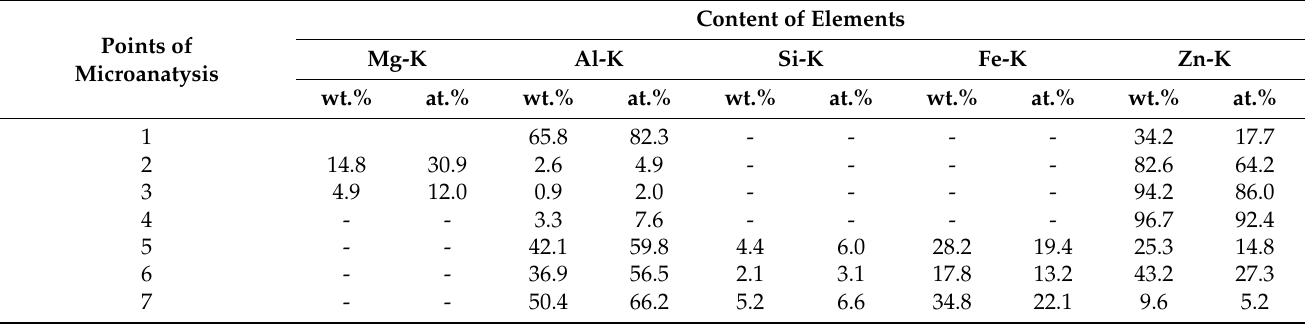
Figure 1. SEM microstructure of the coating obtained in the ZnAl23Mg3Si0.2 bath. Table 3. Chemical composition in micro-areas (EDS) of the coating obtained in the ZnAl23Mg3Si0.2 bath (analysis points as shown in Figure 1).